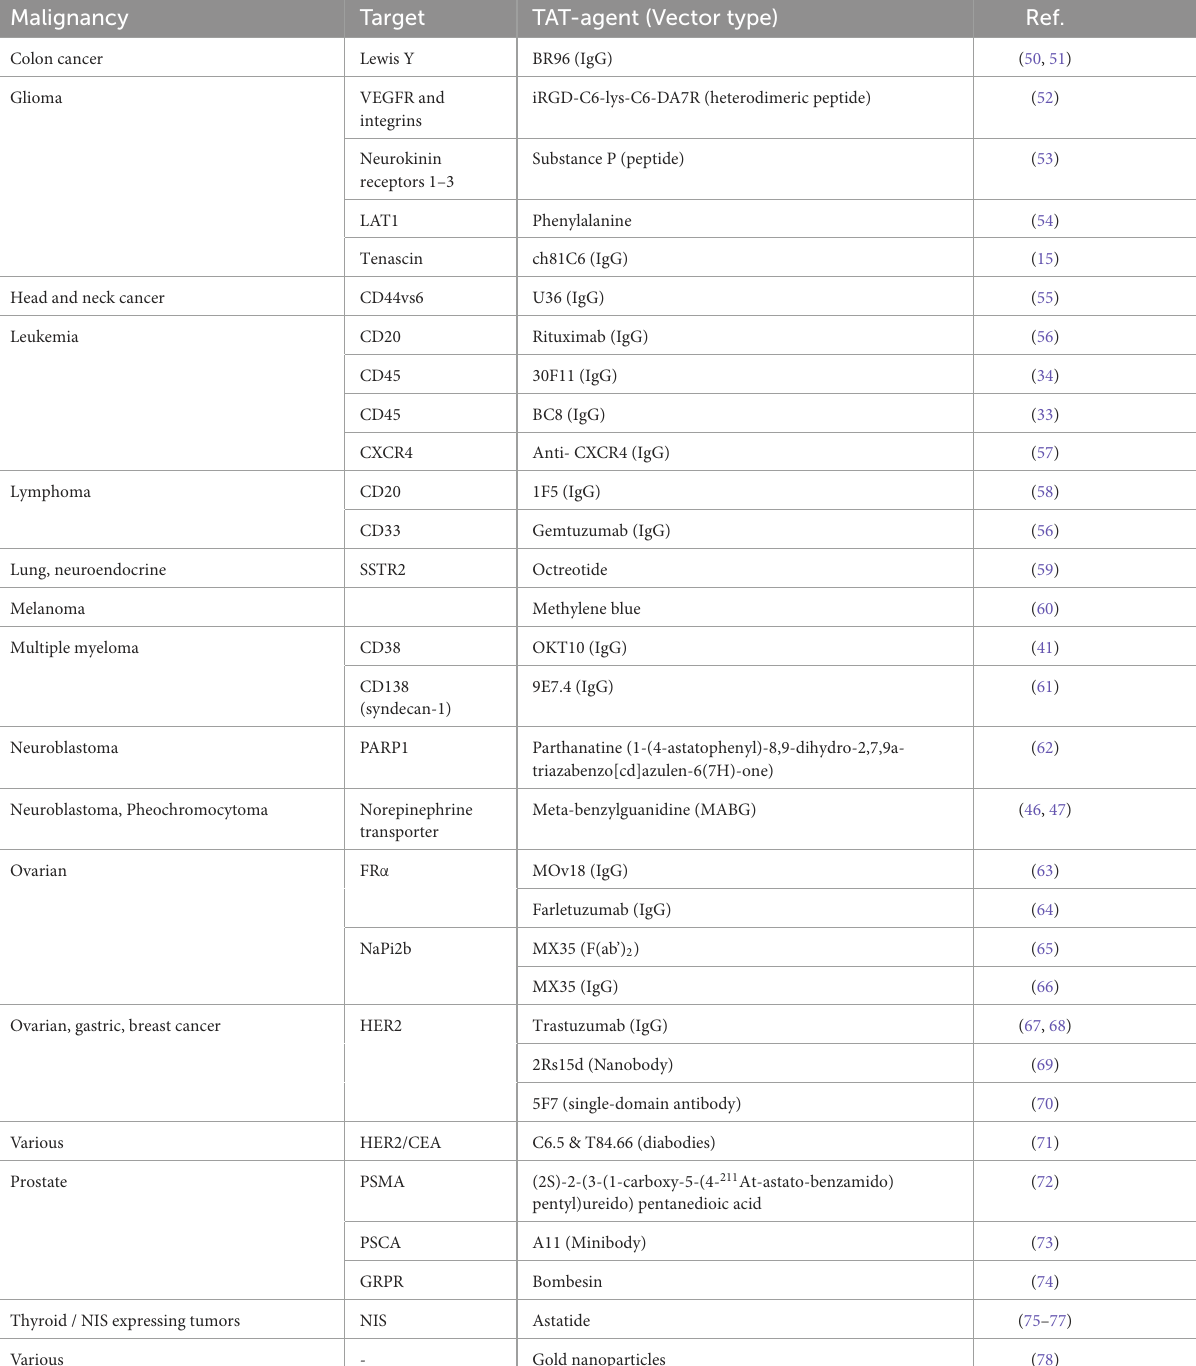
TABLE 3 A selection of studies with various vectors that have been labeled with 211 At. (IgG, immunoglobulin G).